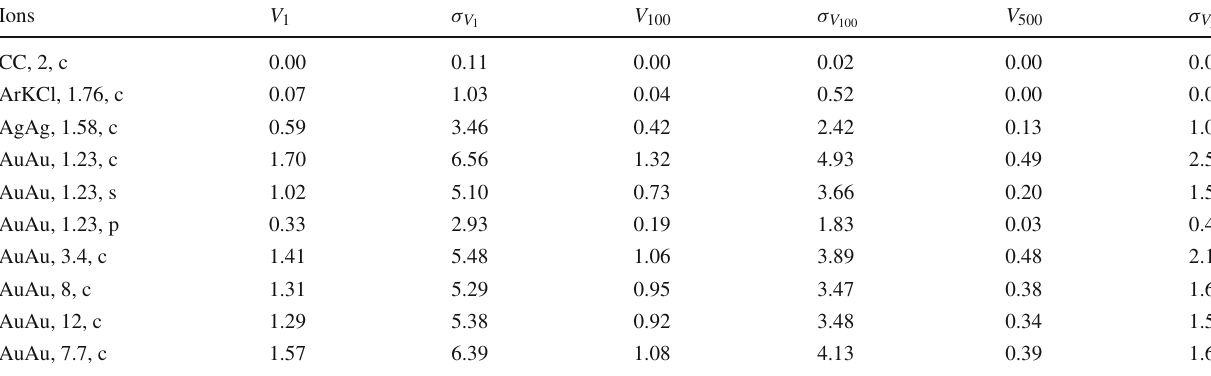
Table 5 Results for X ebe < 0 . 1 and Y ebe < 0 . 1